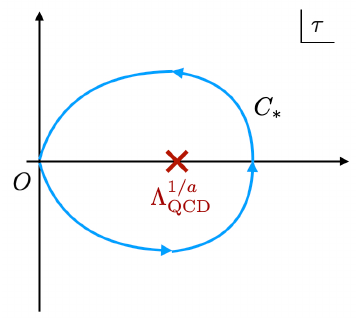
Figure 1 . Integration contour C ∗ surrounding the Landau singularity of the one-loop running coupling constant. [ α s ( q ) diverges at q = Λ QCD